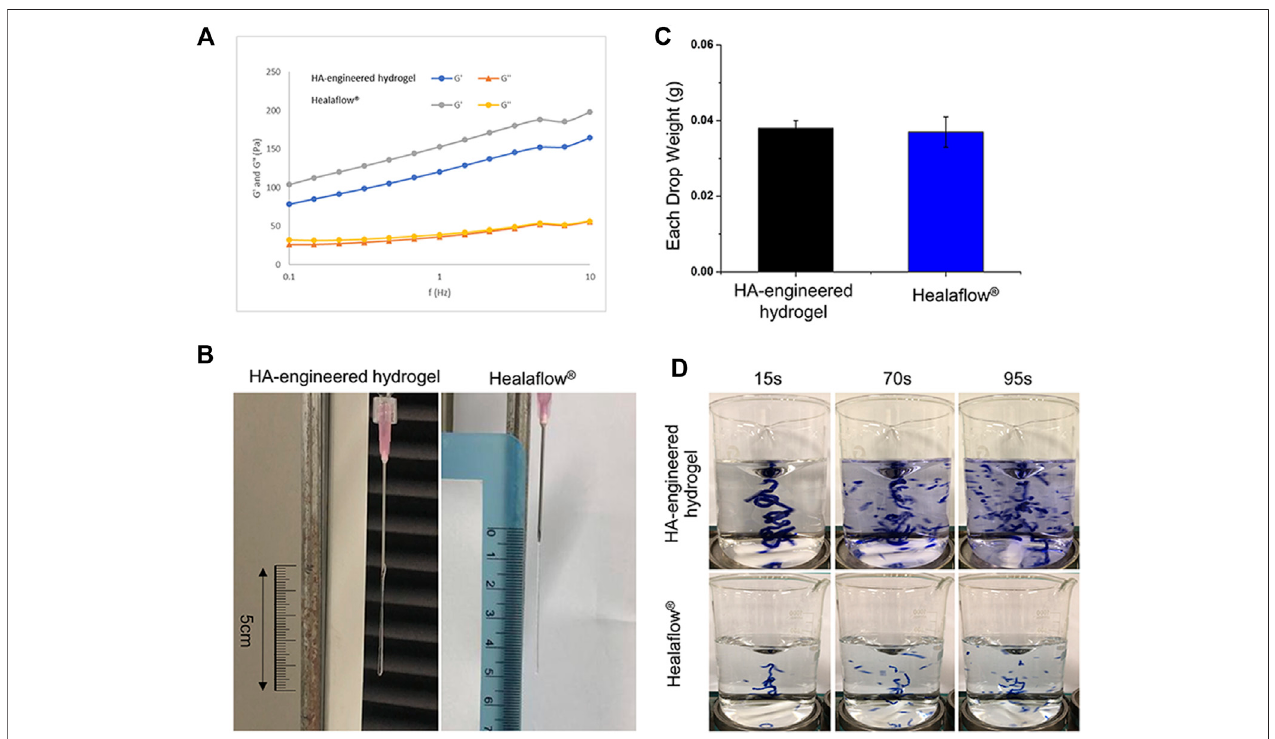
FIGURE 4 | Comparison of characteristics between HA-engineered hydrogel and Heala fl ow ® . (A) G ′ and G ″ of HA-engineered hydrogel and Heala fl ow ® at 2% strain over the frequency sweep from 0.1 to 10 Hz under 25 ° C. (B,C) Cohesiveness characterization of HA-engineered hydrogel and Heala fl ow ® using the drop-weight method. (B) The photographs of HA-engineered hydrogel and Heala fl ow ® when they were about tobreak. (C) The average drop weightof the collected HA-engineered hydrogel and Heala fl ow ® hydrogels ( n = 3). (D) Cohesiveness characterization of HA-engineered hydrogel and Heala fl ow ® using the stained hydrogel dispersion method. The images were captured at the time point of 15, 75, and 90 s after the gel hit the surface.